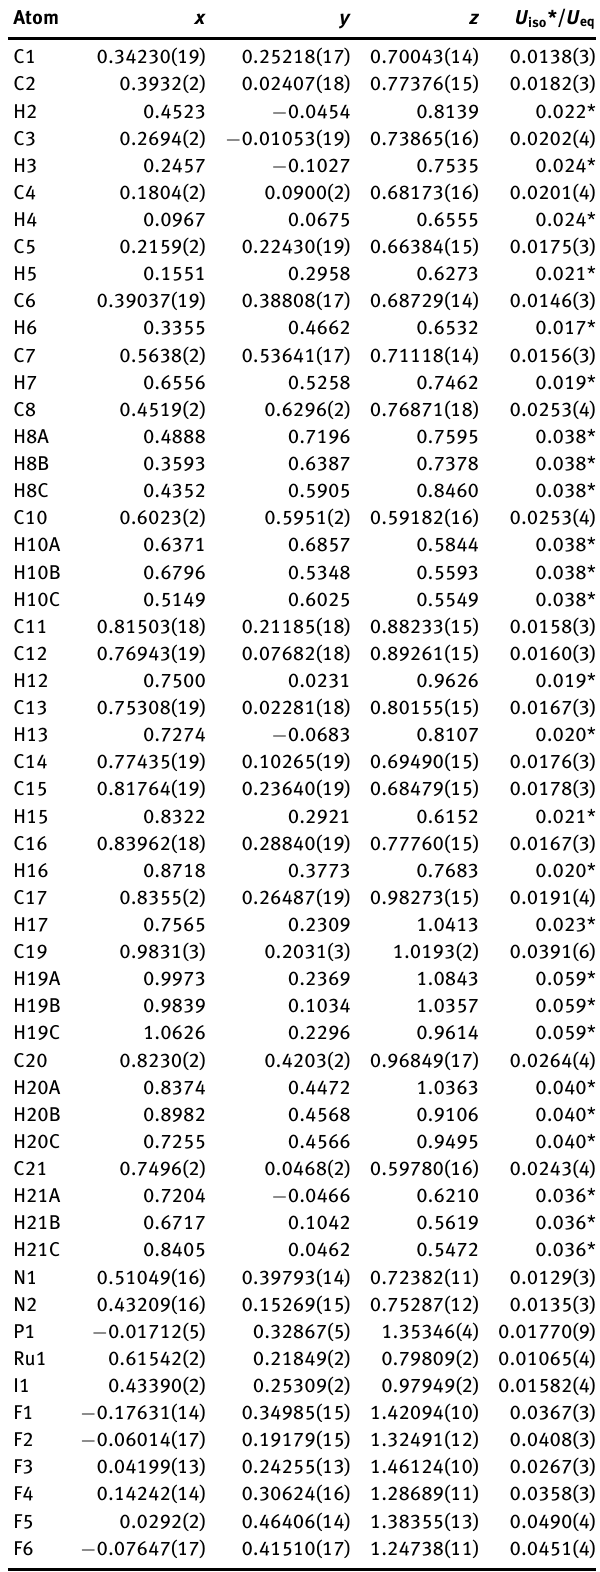
Table 2: Fractional atomic coordinates and isotropic or equivalent isotropic displacement parameters (Å 2